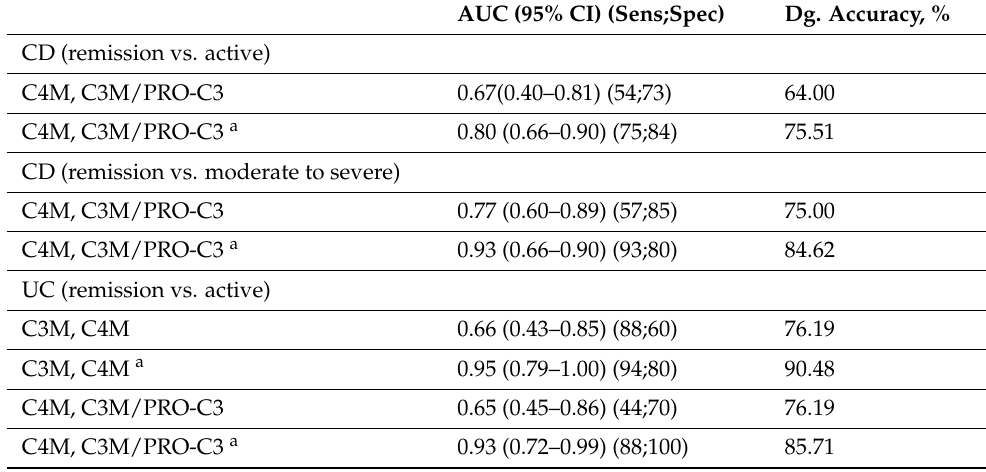
Table 4. Multivariate analysis of combination of biomarkers by logistic